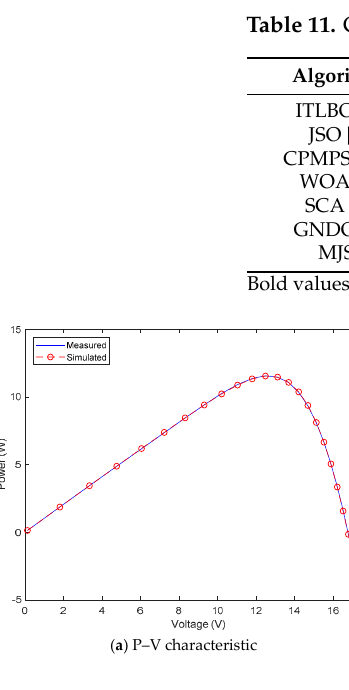
Figure 9. Comparison between the measured and estimated data extracted using MJSO on the PHOTOWATT-PWP201 module.